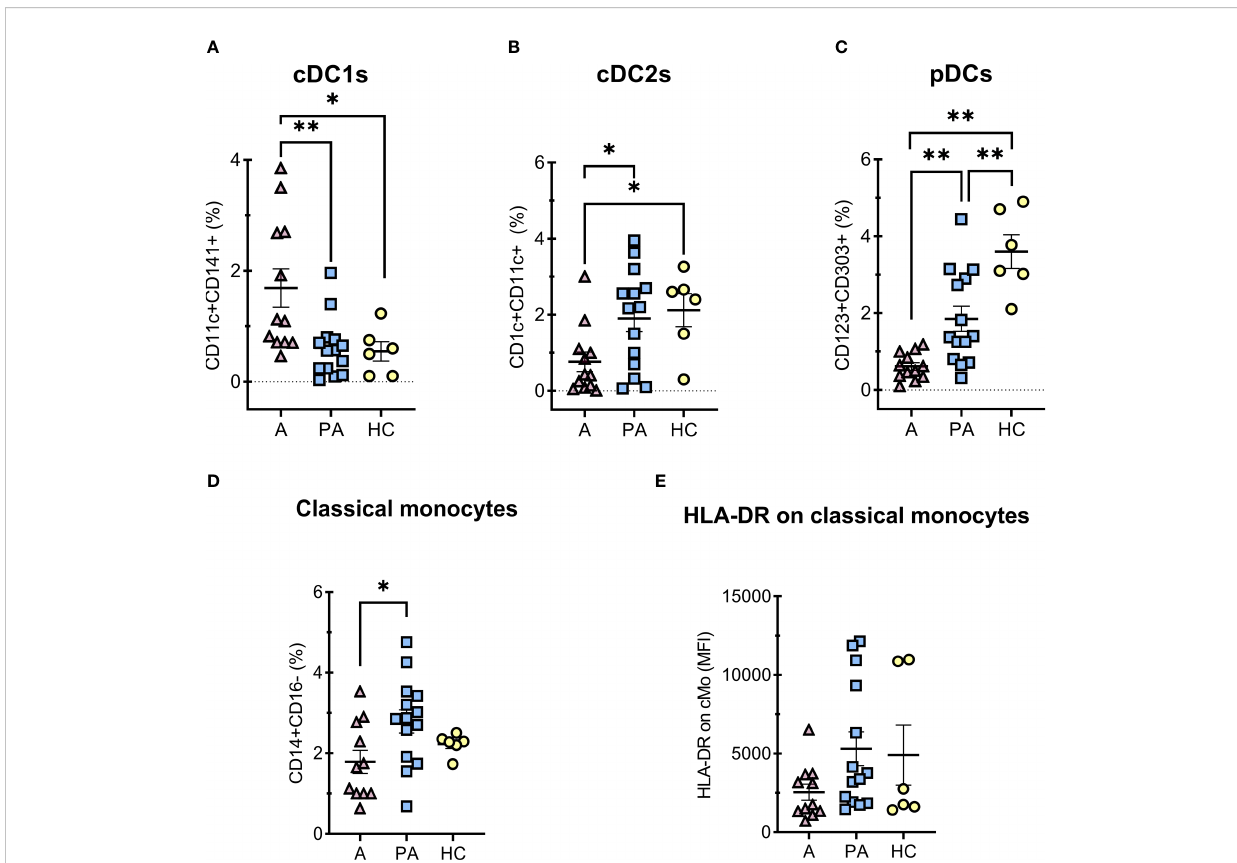
FIGURE 4 Percentages of DCs and classical monocytes in peripheral blood of MIS-C patients in acute (A) compared to convalescent phase (PA) and age- matched healthy controls (HC). A-C, percentages of PBMC, HLA-DR positive and CD14 negative cells (A) conventional type 1 dendritic cells (cDC1s) – CD11c+CD141+HLA-DR+CD14-, (B) conventional type 2 dendritic cells (cDC2s) – CD1c+CD11c+ HLA-DR+CD14-, (C) plasmacytoid dendritic cells (pDCs) – CD123+CD303+CD11c-HLA-DR+CD14-, D ) classical (CD14+CD16-) monocytes percentages of HLA-DR positive vs SSC subset, and E) expression of HLA-DR (MFI) on classical monocytes. Pink and blue shading represents MIS-C patients in acute (A, n = 12) and convalescent (PA, n =14) phase of the illness, respectively. Yellow shading represents HC (n = 6). The Shapiro Wilk test was used to test for normality. Signi fi cance testing between patients by phase of illness (A – acute, PA – convalescent) was performed using paired t-test for normal distribution or Wilcoxon test otherwise. For comparison between patient groups and HC, *P ≤ 0.05 and **P ≤ 0.01 were determined by using unpaired t-test if the distribution was normal and Mann-Whitney test otherwise. Data are presented as median with